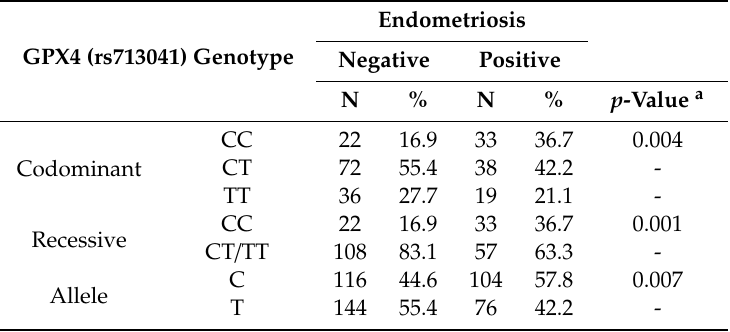
Table 2. Frequencies of GPX4 (rs713041) polymorphism among women with endometriosis or normal control group.